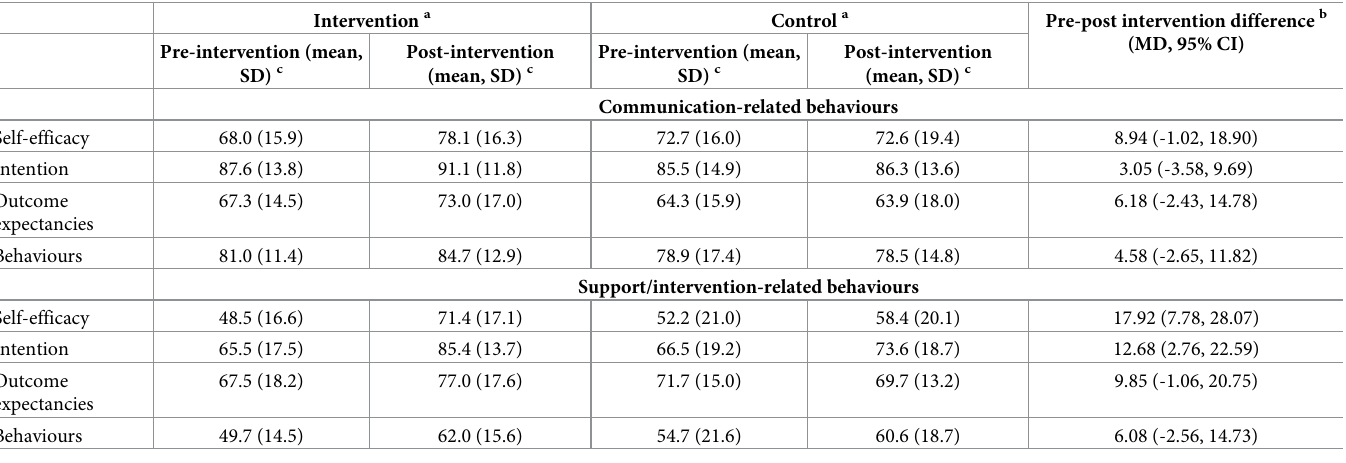
Table 3. Pre- and post-intervention scores for communication- and support/intervention-related